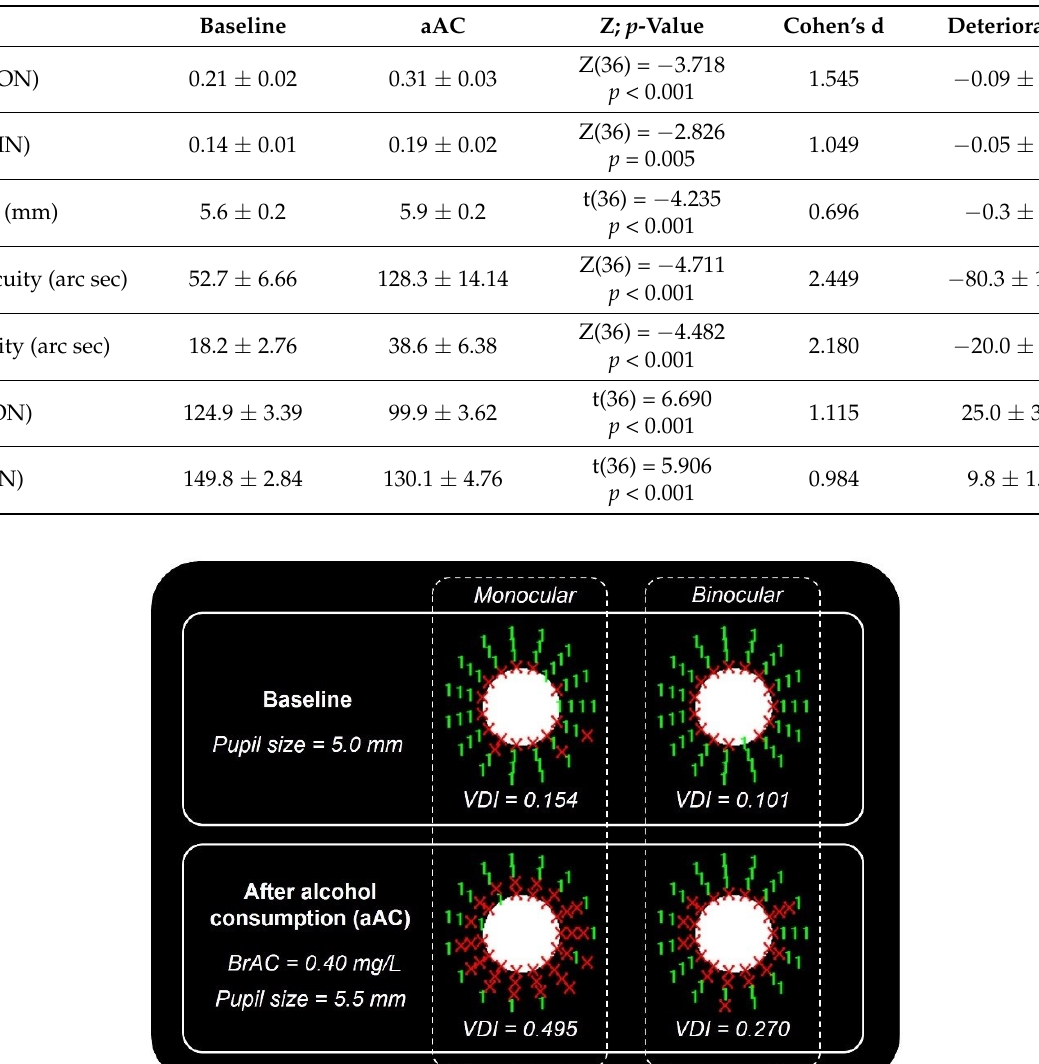
Table 1. Mean values of the parameters for the different visual functions analyzed under the two experimental conditions (baseline and after alcohol consumption, aAC): visual disturbance index (VDI), stereoacuity (near and distance), and contrast sensitivity (CS). Both VDI and CS monocular (MON) and binocular (BIN) values are given for the VDI and CS. Standard errors as well as statistical results and p -values are indicated.